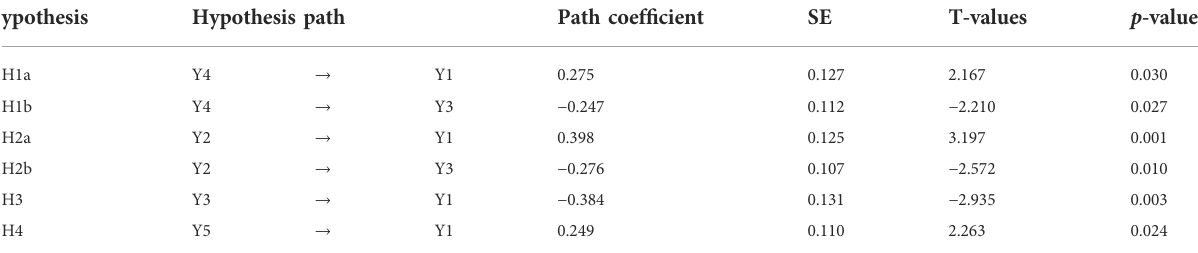
TABLE 2 Estimation